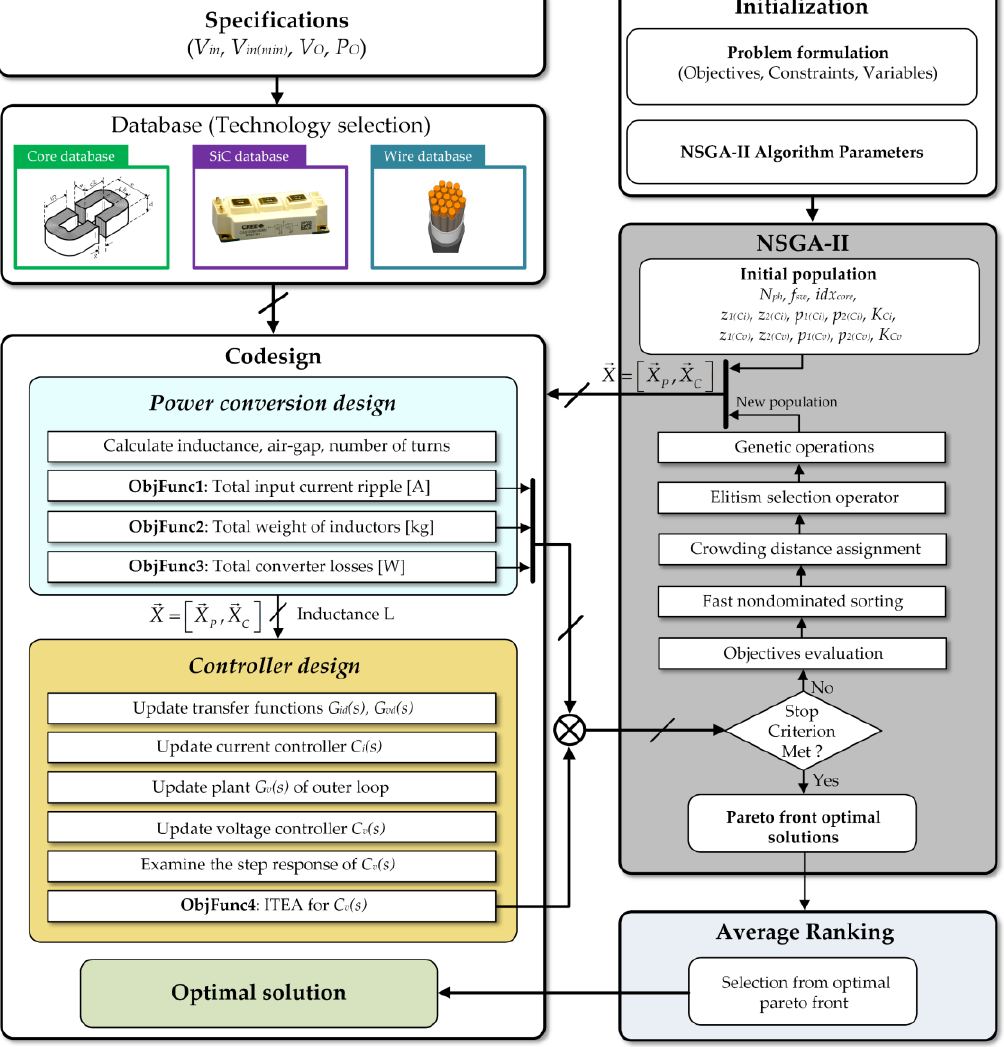
Figure 4. Proposed simultaneous codesign optimization framework.